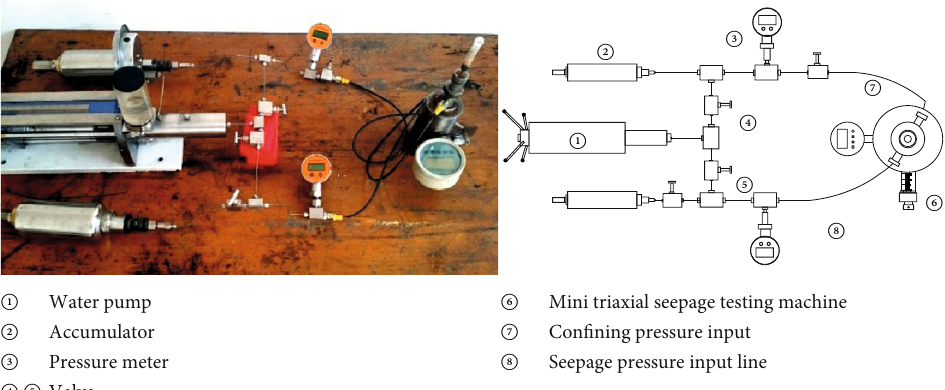
Figure 4: Seepage test system for real-time CT scanning and its schematic: ① water pump, ② accumulator, ③ pressure meter, ④ and ⑤ valve, ⑥ mini triaxial seepage testing machine, ⑦ con fi ning pressure input line, and ⑧ seepage pressure input line.